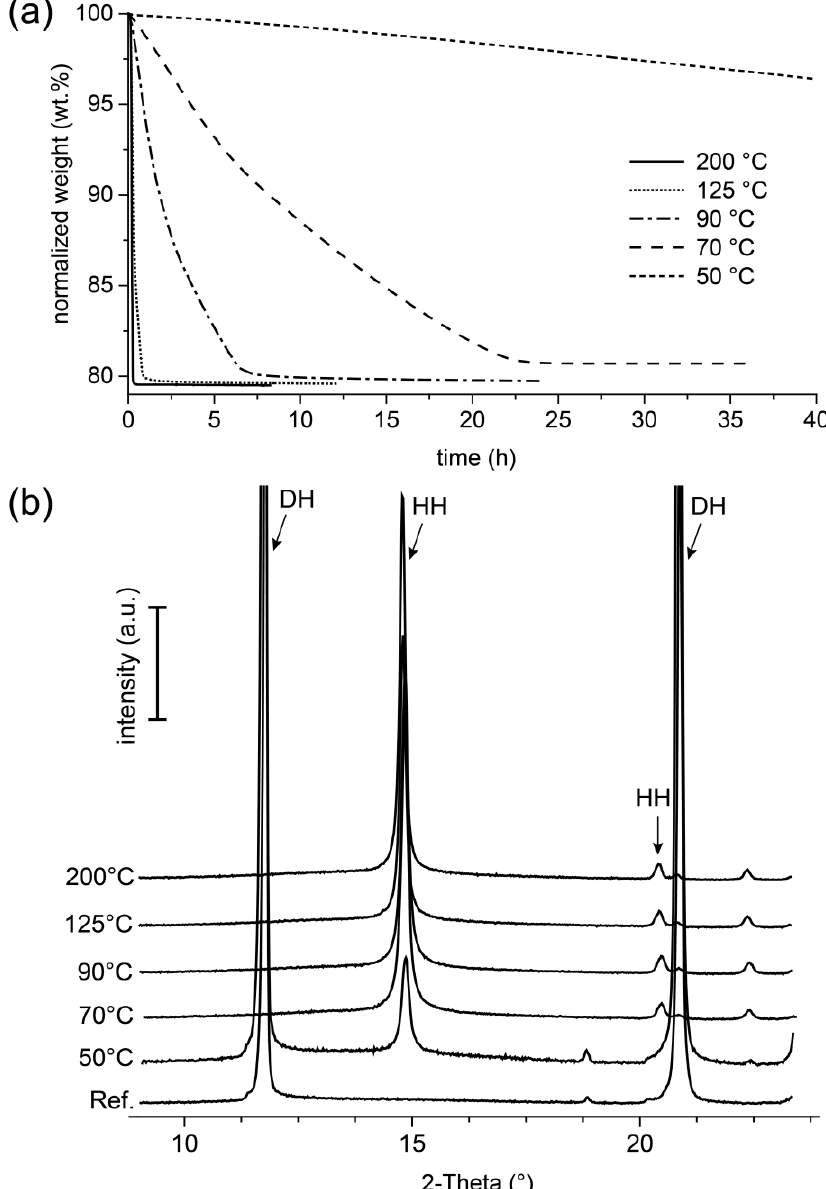
Figure 9. Results of the isothermal thermo-gravimetric investigations at 50 ◦ C, 70 ◦ C, 90 ◦ C, 125 ◦ C, and 200 ◦ C ( a ) and the respective mineralogical characterization of the reaction products by means of XRD ( b ) (DH: gypsum, HH: hemihydrate, a.u.: arbitrary units).